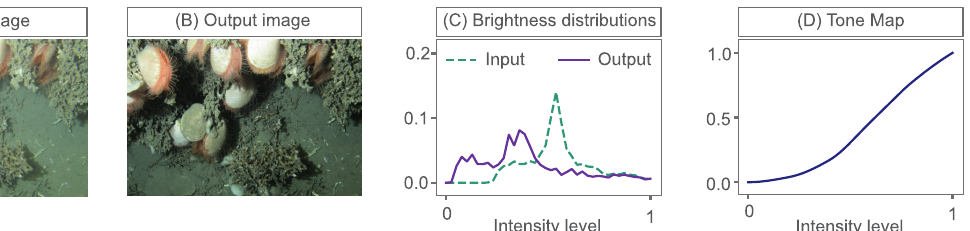
Figure 1. An example of tone mapping: ( A ) an input image, ( B ) an enhanced output image, ( C ) their corresponding brightness distributions and ( D ) the tone map that matches the input histogram to the output histogram.